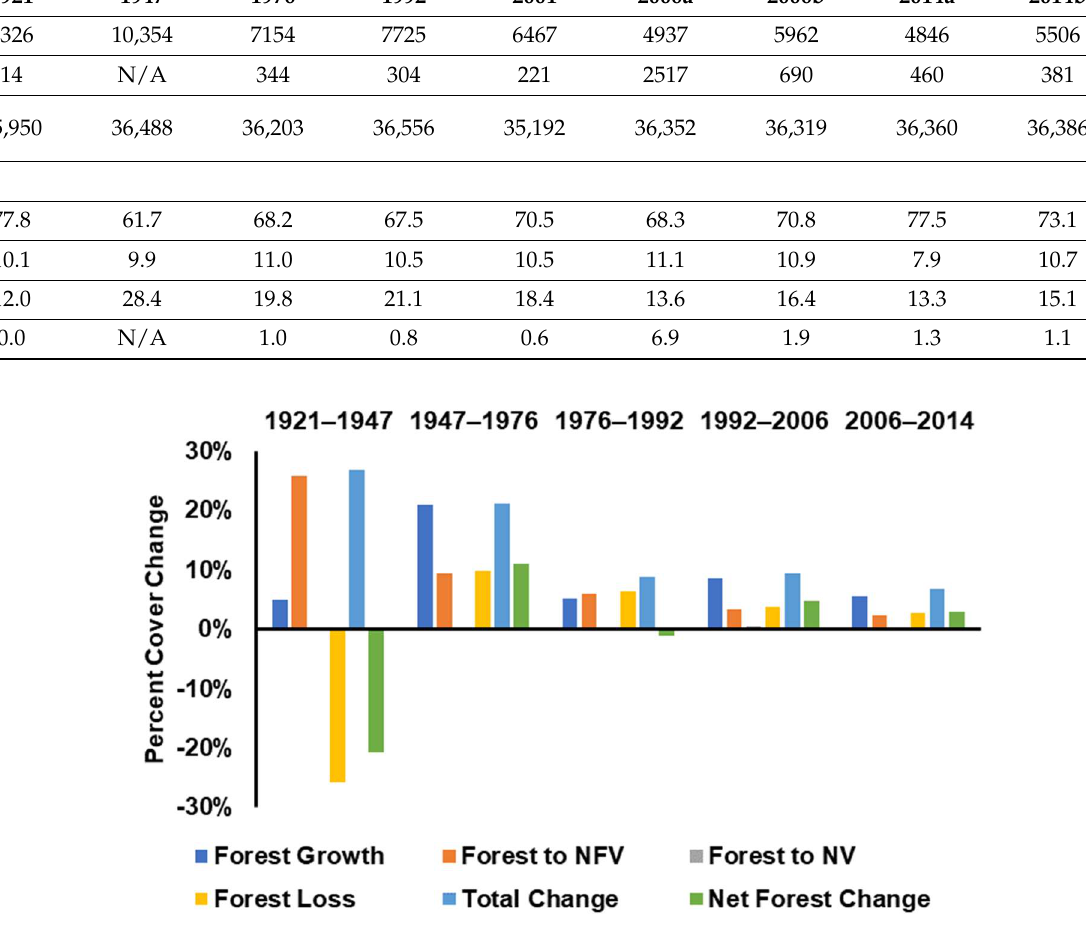
Figure 3. Summary of forest cover change on Babeldaob Island, Palau from 1947 to 2006, by percentage of relative forest or total non-mangrove land cover.